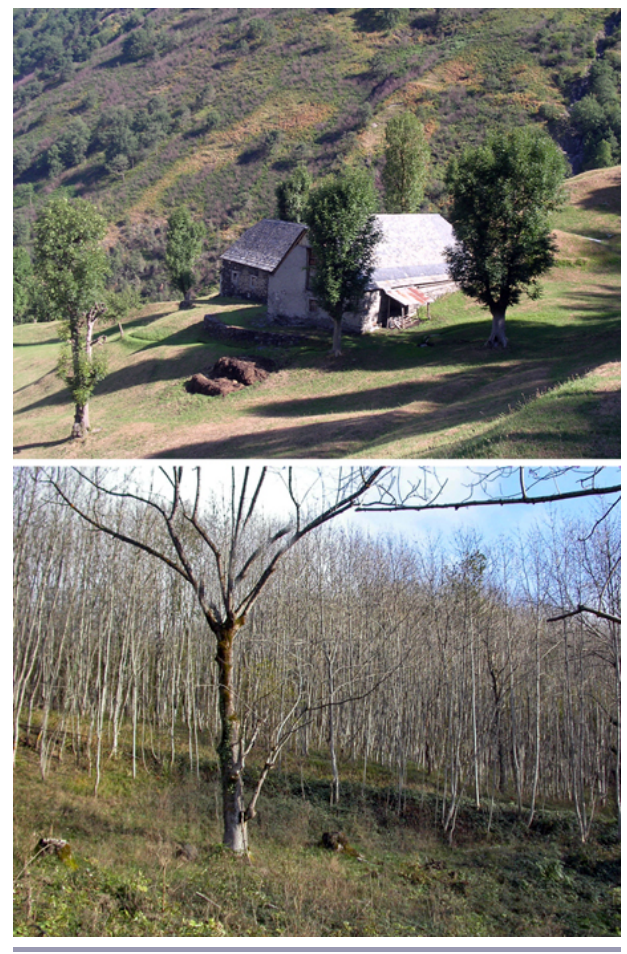
Fig. 8 . The evolution of ashtree-based rural forests in the Pyrenees, from traditional stands around the farm (above) to dense thickets colonizing abandoned pastures